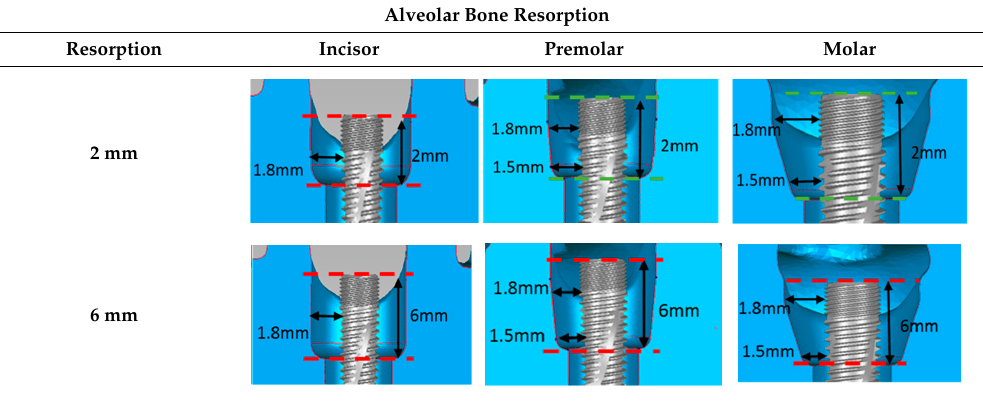
Figure 1. Peri-implantitis model design. ( a ) Computer-aided design (CAD) model of peri-implantitis scanned from a digital jaw model. ( b ) Shallow and deep peri-implant intra-bony defects designed with 2 mm and 6 mm depth. ( c ) Acrylonitrile butadiene styrene (ABS) 3D-printed model with peri-implantitis at mandibular incisor, premolar, and molar positions.